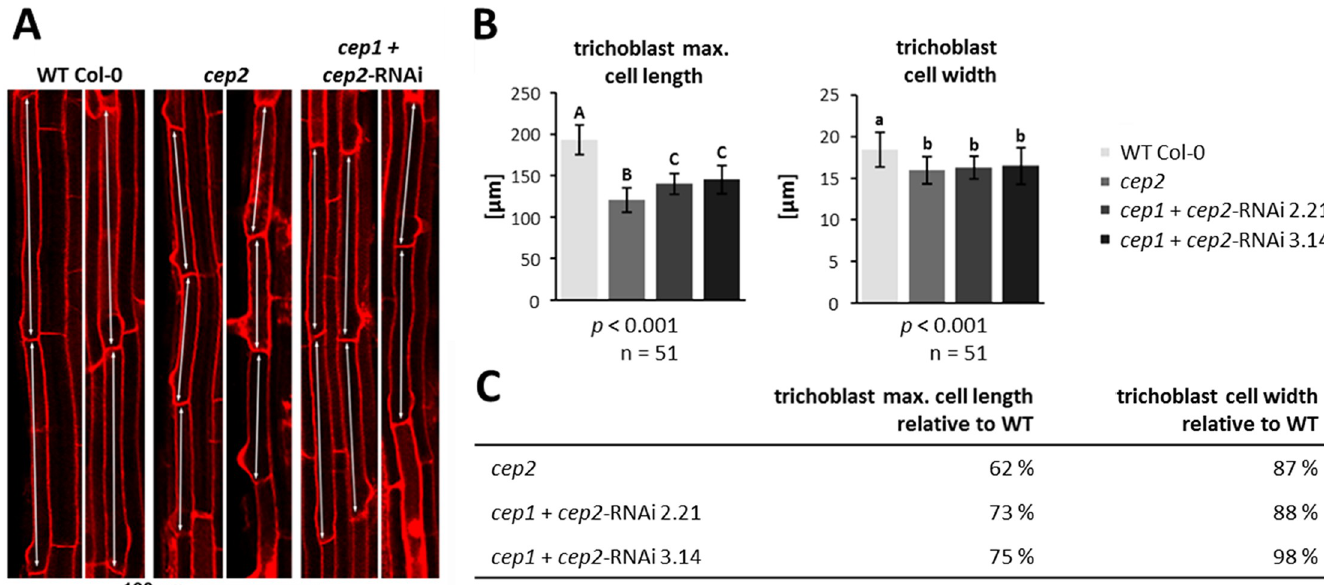
Fig 7. CEP2 loss of function results in shortening the cell length and cell width of the longest trichoblasts (double arrows) in the root elongation zone at the level of the transition from the rapid elongation zone to the late elongation zone. The residual CEP2 activity in cep1 cep2 double ko/kd mutants ( cep1 + cep2- RNAi) results in prolonged trichoblasts as compared to cep2 ko mutant plants, but shorter as compared to trichoblasts in WT plants. (A) 7 days old seedlings of WT, cep2 ko and cep1 cep2 double ko/kd plants were stained with propidium iodide and analyzed by CLSM (single pictures, 200-fold magnification). Two examples of propidium iodide stained roots are presented for each genotype. (B) Comparison of the trichoblast cell length (left) and the width (right) in 7 days old seedlings of WT plants with cep2 ko and cep1 cep2 double ko/kd mutants ( cep1 + cep2- RNAi; lines 2.21 and 3.14). Columns are marked with different letters indicating statistically different groups for the trichobalst cell length or with similar letters indicating groups not statistically different for trichoblast cell width according to the ANOVA-and Duncan test ( p < 0.001). (C) Trichoblast cell length expressed as percentage of WT plants. Data represent the respective means of two independent experiments (biological replica) comprising 8 and 9 seedlings per line, respectively, with three trichoblast cells evaluated per seedling.